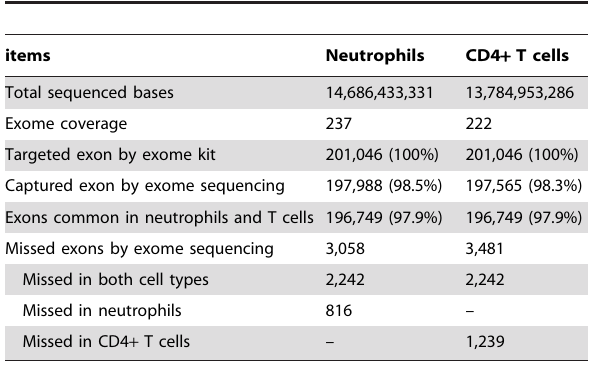
Table 1. Exome data collected from neutrophils and CD4 + T cells.